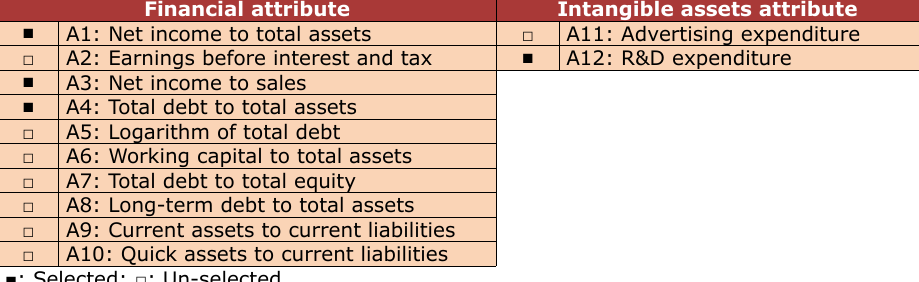
Table 3. The description of selected attribute